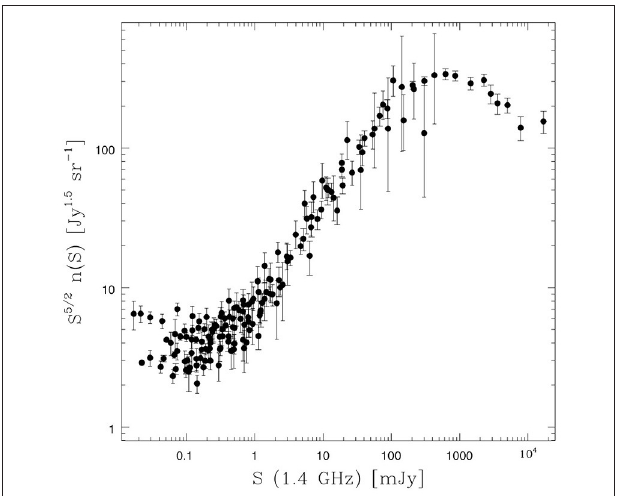
FIGURE 1 | The Euclidean normalized 1.4 GHz source counts derived from various radio surveys. See Figure 14 of Padovani (2016) for